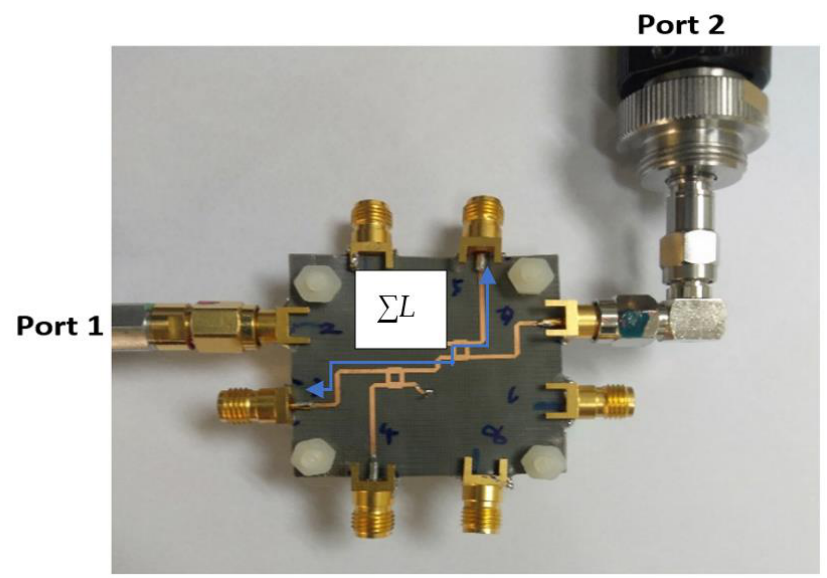
Figure 22. Transmission measurement of internal design from input to output port.